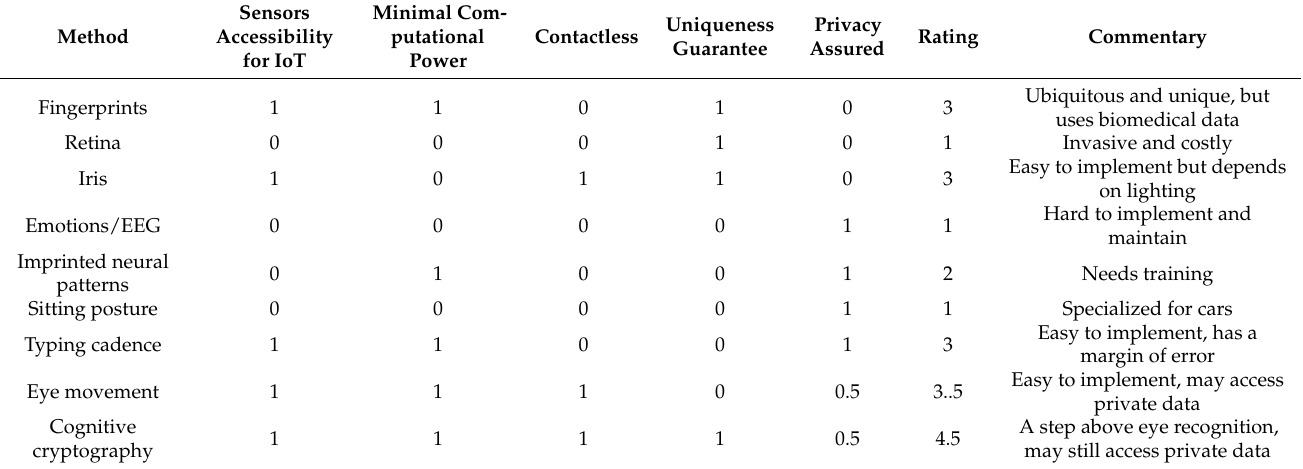
Table 1. Comparison of features for selected personal patterns and their